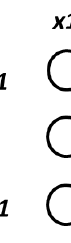
Figure 11. The principle of how pixels are affected by adjacent pixels.